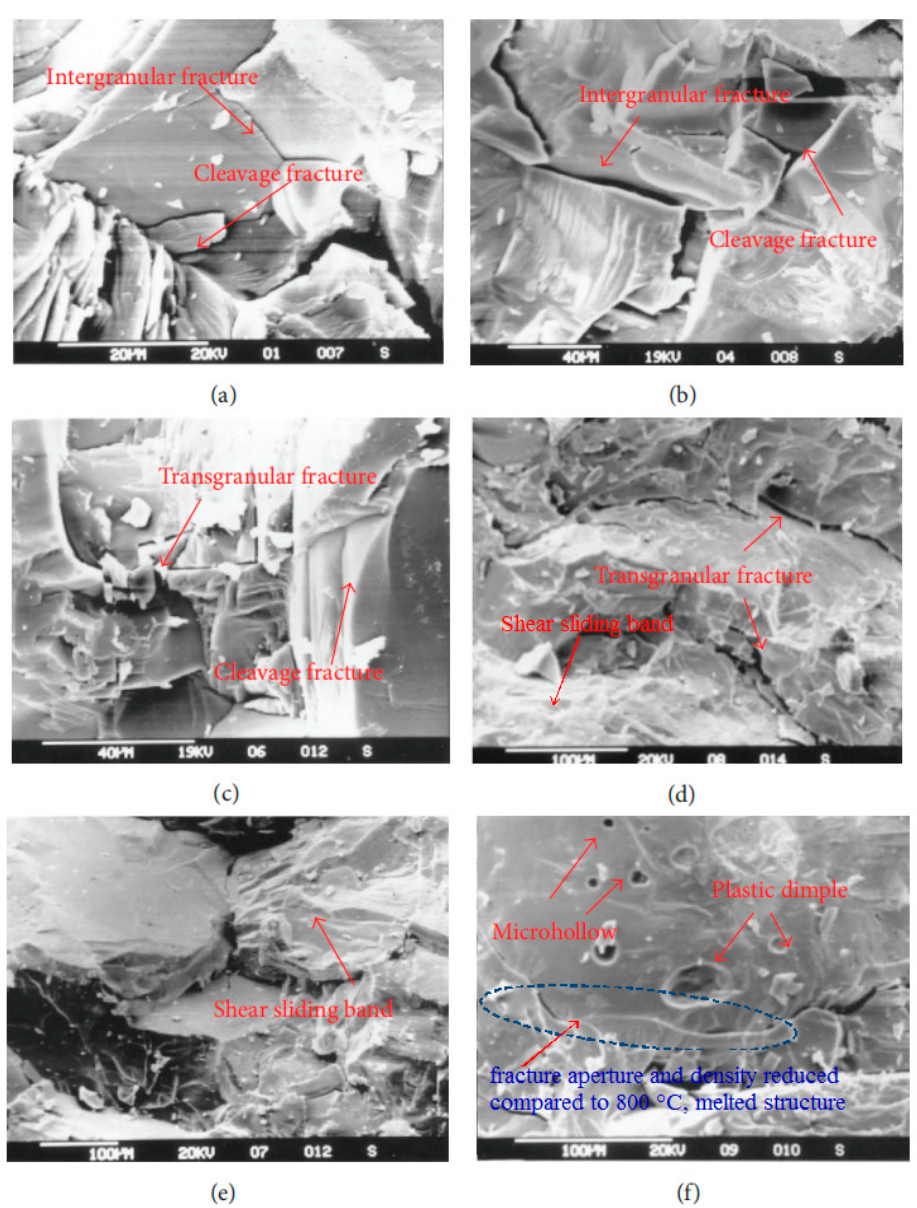
Figure 19. SEM images of fracture surfaces in rock samples at different temperature: ( a ) 25 °C; ( b ) 200 °C; ( c ) 500 °C; ( d ) 800 °C; ( e ) 1000 °C; ( f ) 1200 °C [93].